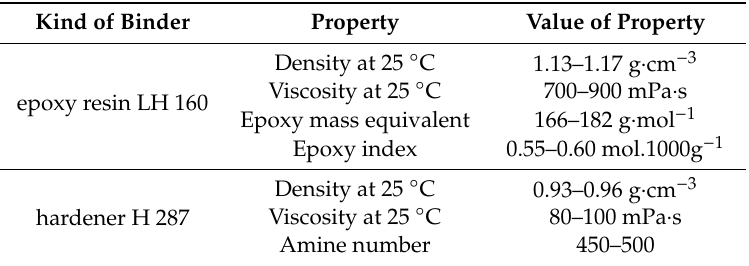
Table 2. The characteristics of epoxy resin LH 160 and hardener H 287